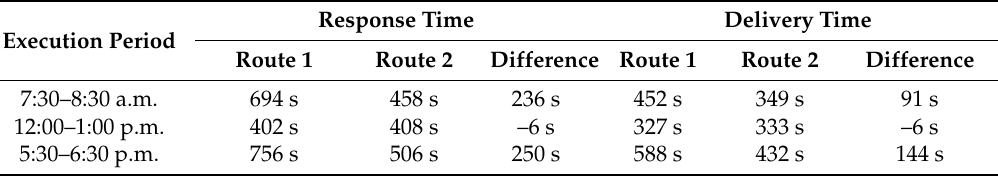
Figure 10. The second suggested route is chosen, along Jianguo elevated road, which is uncongested. Table 3. Comparison of response and delivery time along Routes 1 and 2.